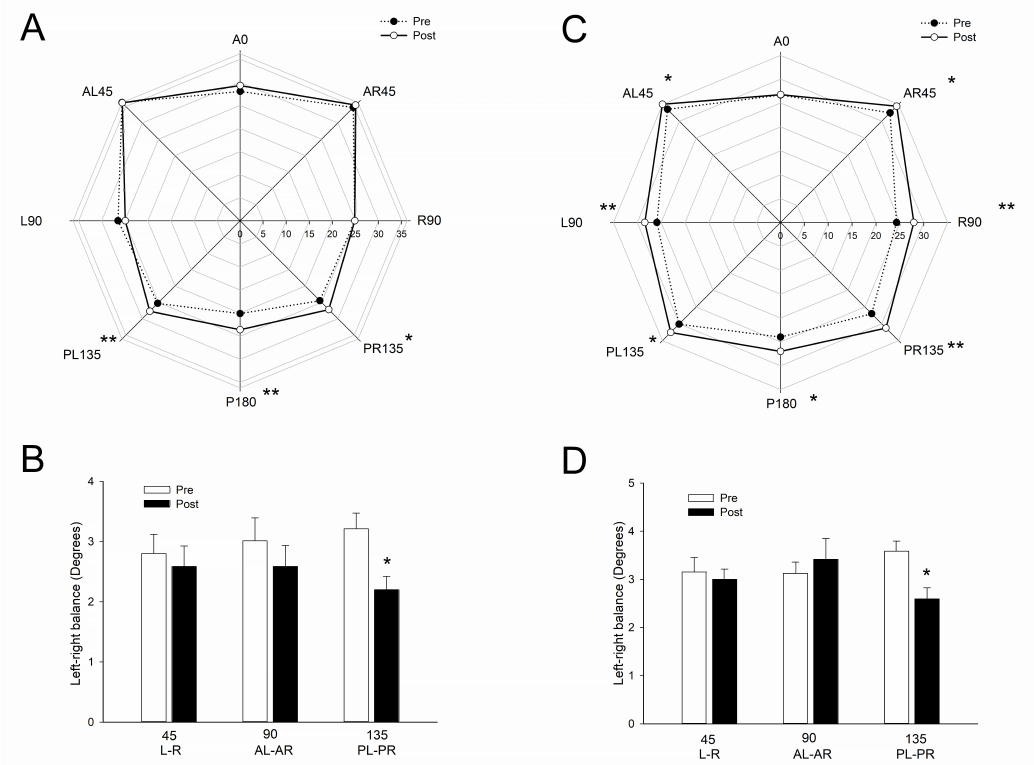
Fig. 3. Effects of two-weeks off-season training on ROM (A and C) and core dynamic balance (B and D) by Air balance 3D in MSP (A and B) and HSP (B and D). Data are presented as means ± SD. * p < 0.05, ** p < 0.01 vs. Pre by paired t -test. MSP, Middle-school soccer players; HSP, High-school soccer player; ROM, range of